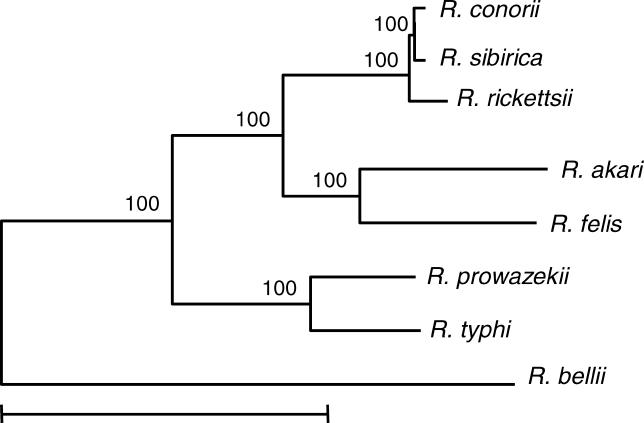
Phylogenetic Relationships of R. bellii with Other RickettsiaeThe tree was built using the comparison of concatenated nucleotide sequences of the 16S rDNA, gltA, pheS, pheT, nusA, valS, and smpB genes using the neighbor-joining method with Kimura-2 parameter. Bootstrap values are indicated at the nodes. The tree was rooted using the orthologous sequences of Anaplasma marginale as an outgroup (not shown). The scale bar corresponds to 5% divergence in nucleotide sequences.